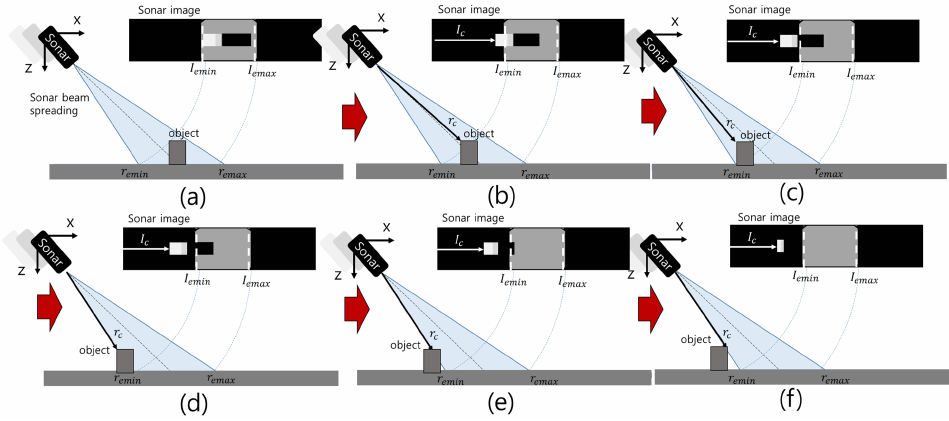
Figure 7. Stepwise changes in the sonar image when the sonar approaches an object from ( a – f ). The ROI is defined by calculating r emin . Let the sonar return data be I ( i , j ) and let the i -th row of I ( i , j ) be I r ( i ) , where i = { 1 . . . n } and j = { 1 . . . m } . Given the altitude, h r